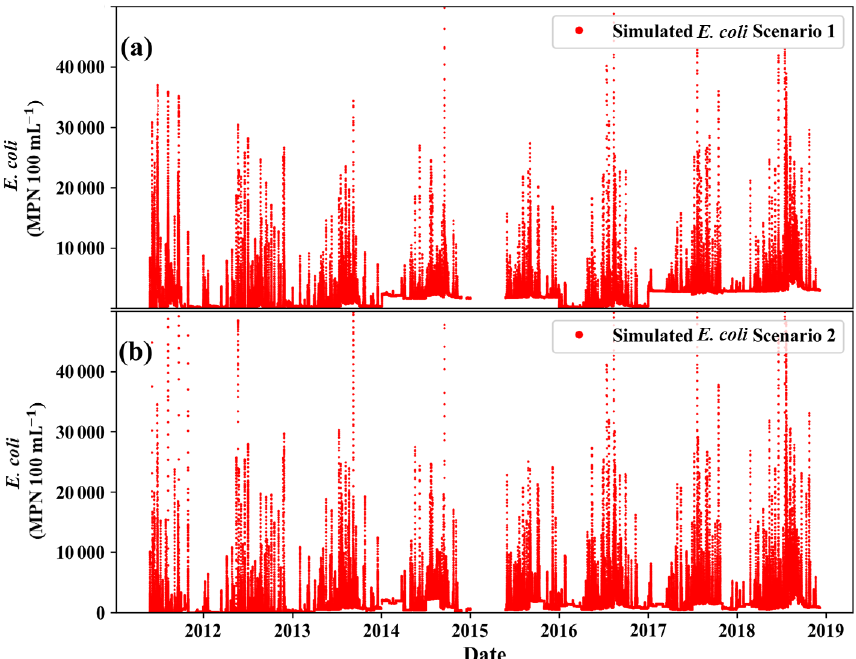
Figure 10. Simulated E. coli concentration with changes in E. coli sources with land-use change scenarios. Scenario 1 used land-use change and bacterial source information. Scenario 2 used the bacterial source by the fraction of each land